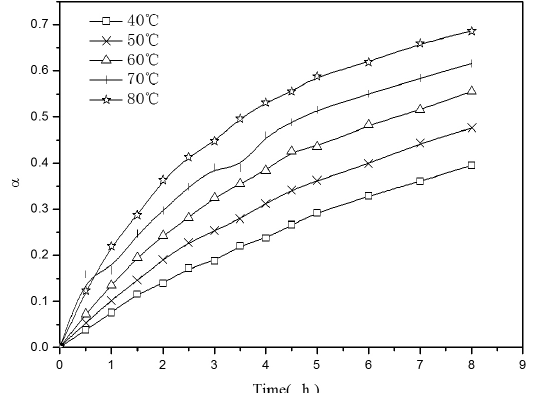
Figure 9. Plots of α /(1- α ) - t for H-IPNs with 20 wt % H different temperatures.